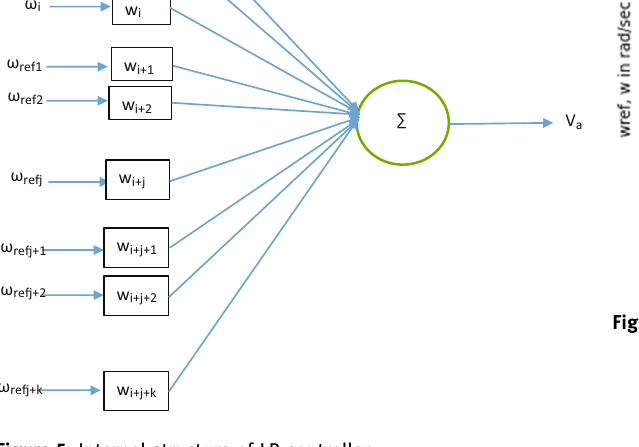
Figure 5: Internal structure of LR controller.